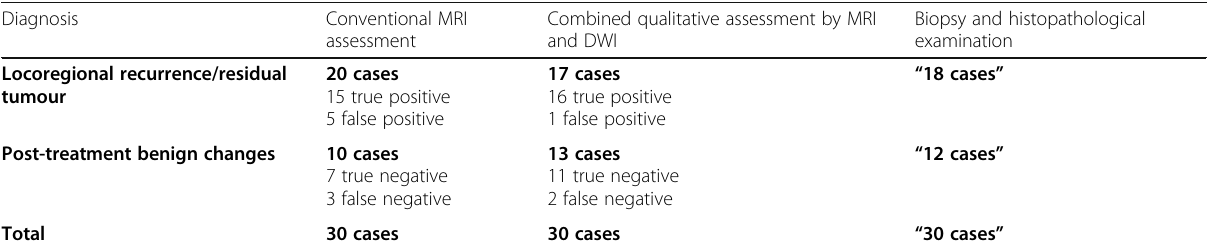
Table 2 Magnetic resonance imaging (MRI) assessment and combined qualitative assessment by MRI and diffusion-weighted imaging (DWI)